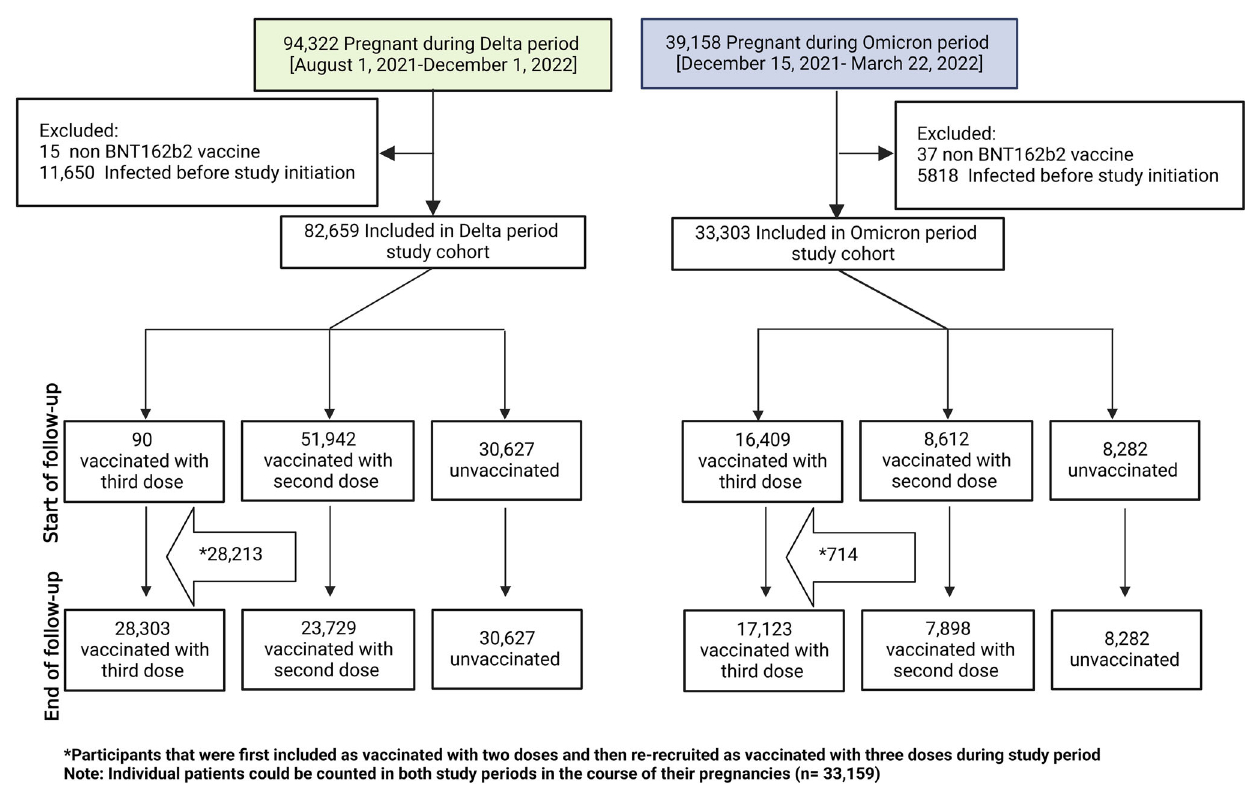
Fig. 2 | Study population and fl ow chart of cohort selection. The fl ow chart shows the three comparison groups investigated during the two study periods.